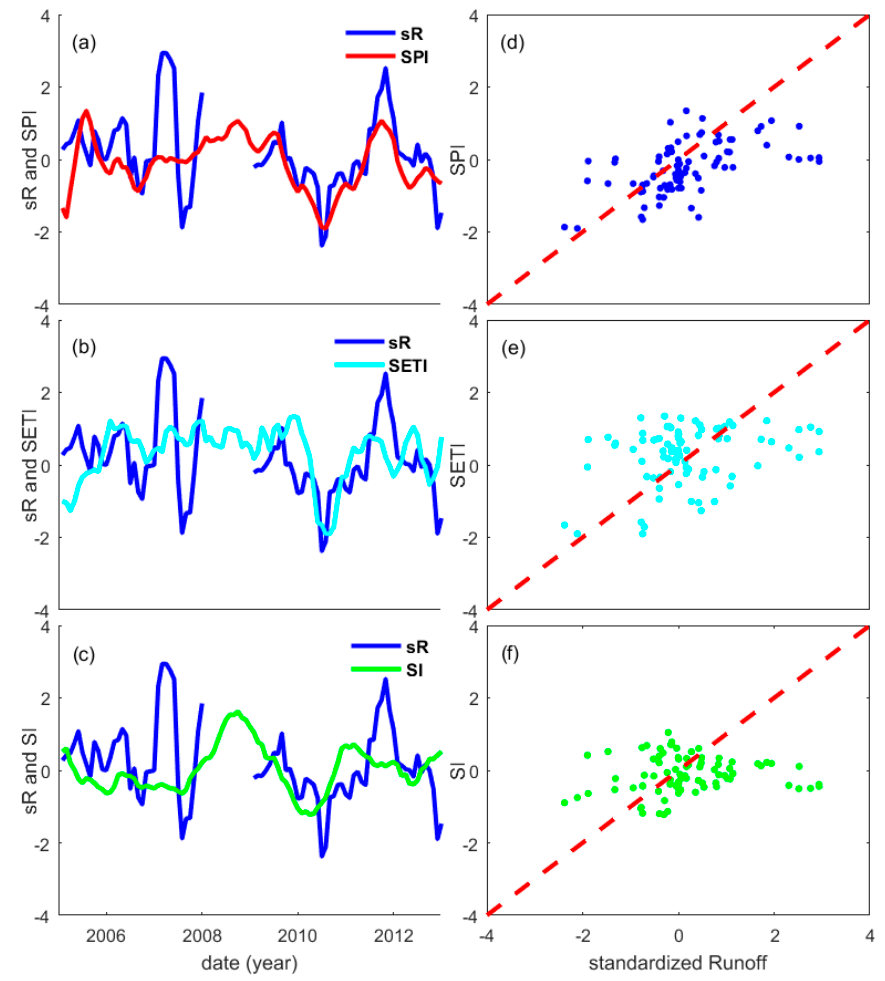
Figure 6. Runoff time series in the standardized form, plotted against standardized, remotely-sensed hydrological variables (RSHVs), at My Thuan: ( a ) and ( d ) Standardized Precipitation Index (SPI), ( b ), and ( e ) Standardized Evapotranspiration Index (SETI), and ( c ), and ( f ) severity index (SI) values. The two columns represent the time series of (left) the standardized runoff and the standardized RSHV, and (right) their scatter plots.